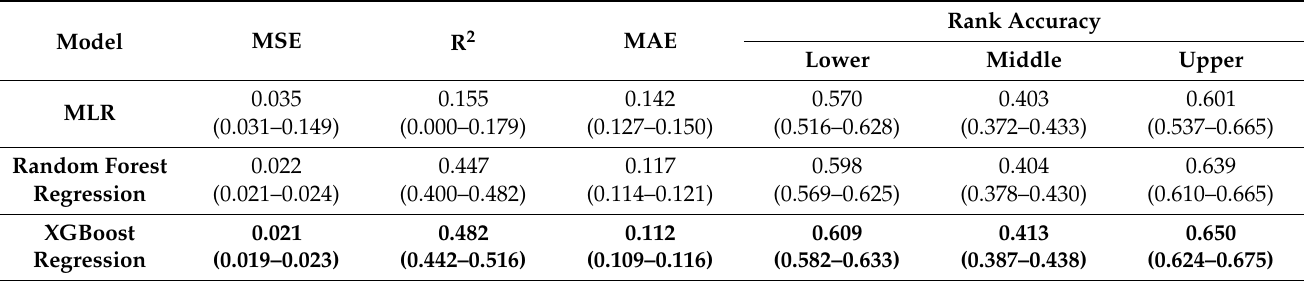
Table 3. Performances of MLR, Random Forest, and XGBoost models trained on Tags feature set. Results are reported alongside 95% confidence intervals (calculated using 1000 bootstrap